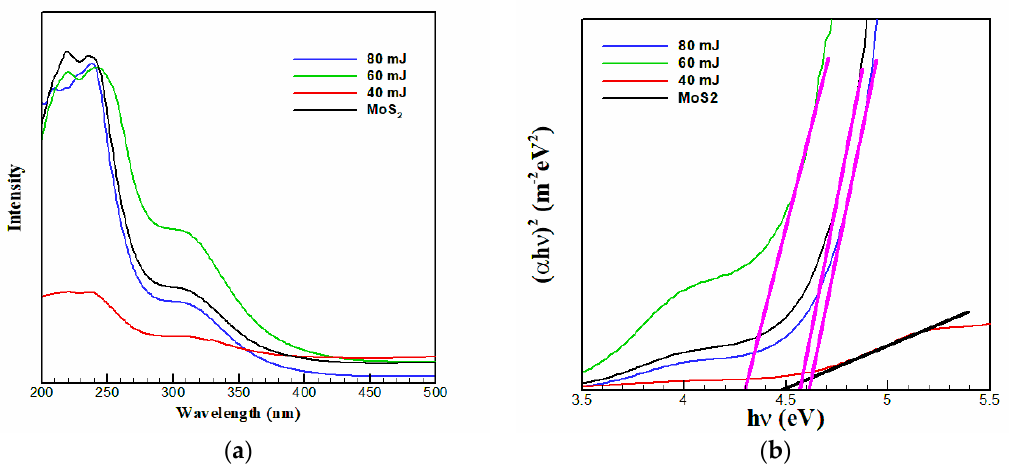
Figure 5. UV-Vis absorption spectrum of few-layered MoS 2 nanosheets under various laser energies from 40 to 80 mJ.